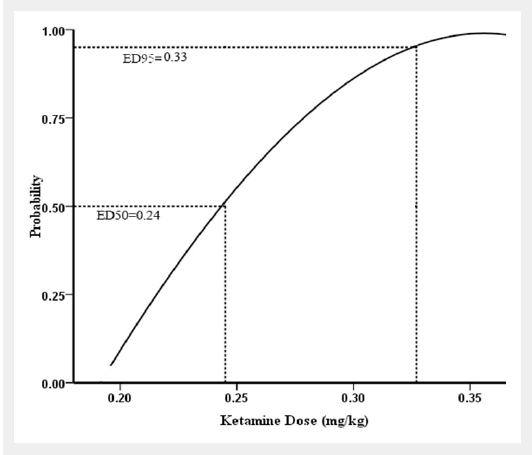
Sequence of patients receiving ketamine in group K. The quality of analgesia was measured using VAS (from 0 to 10) and was defined as ineffective (VAS score >3) or effective (VAS score ≤3).